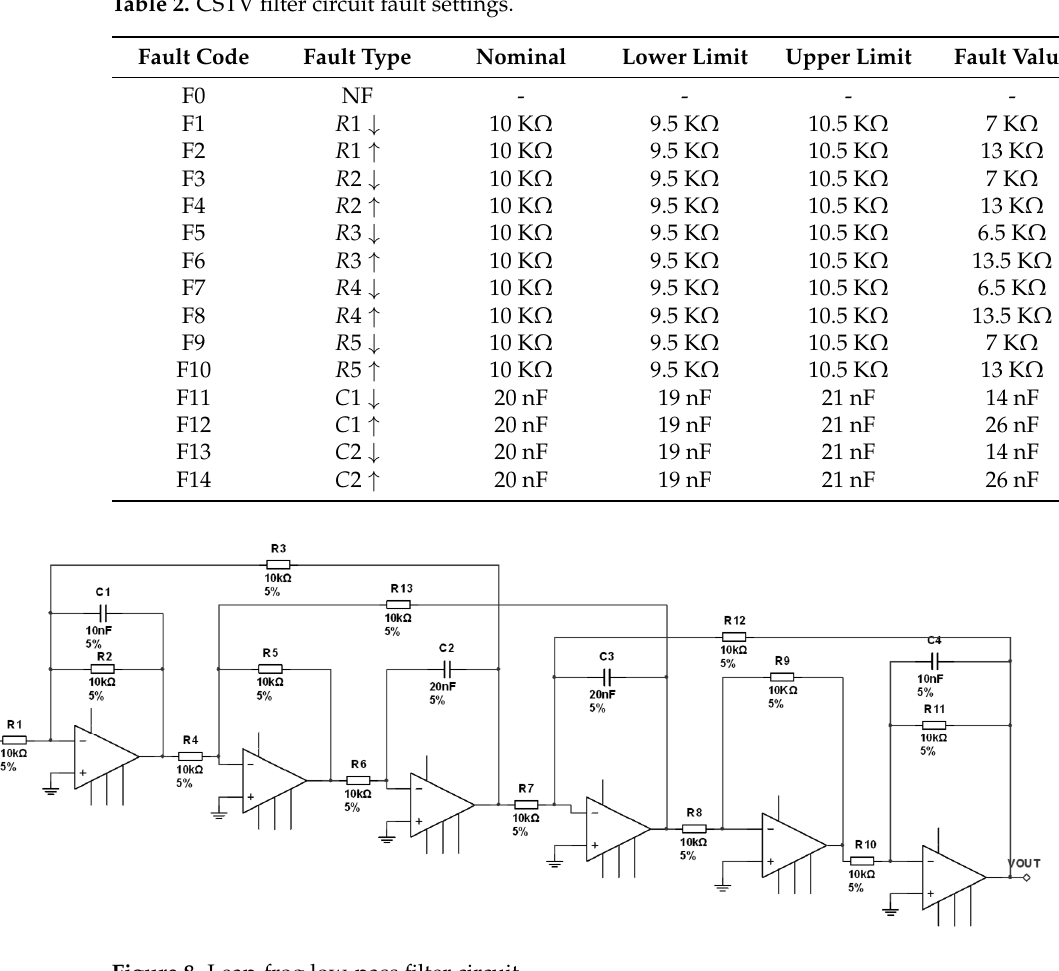
Figure 7. CSTV filter circuit. Table 2. CSTV filter circuit fault settings.